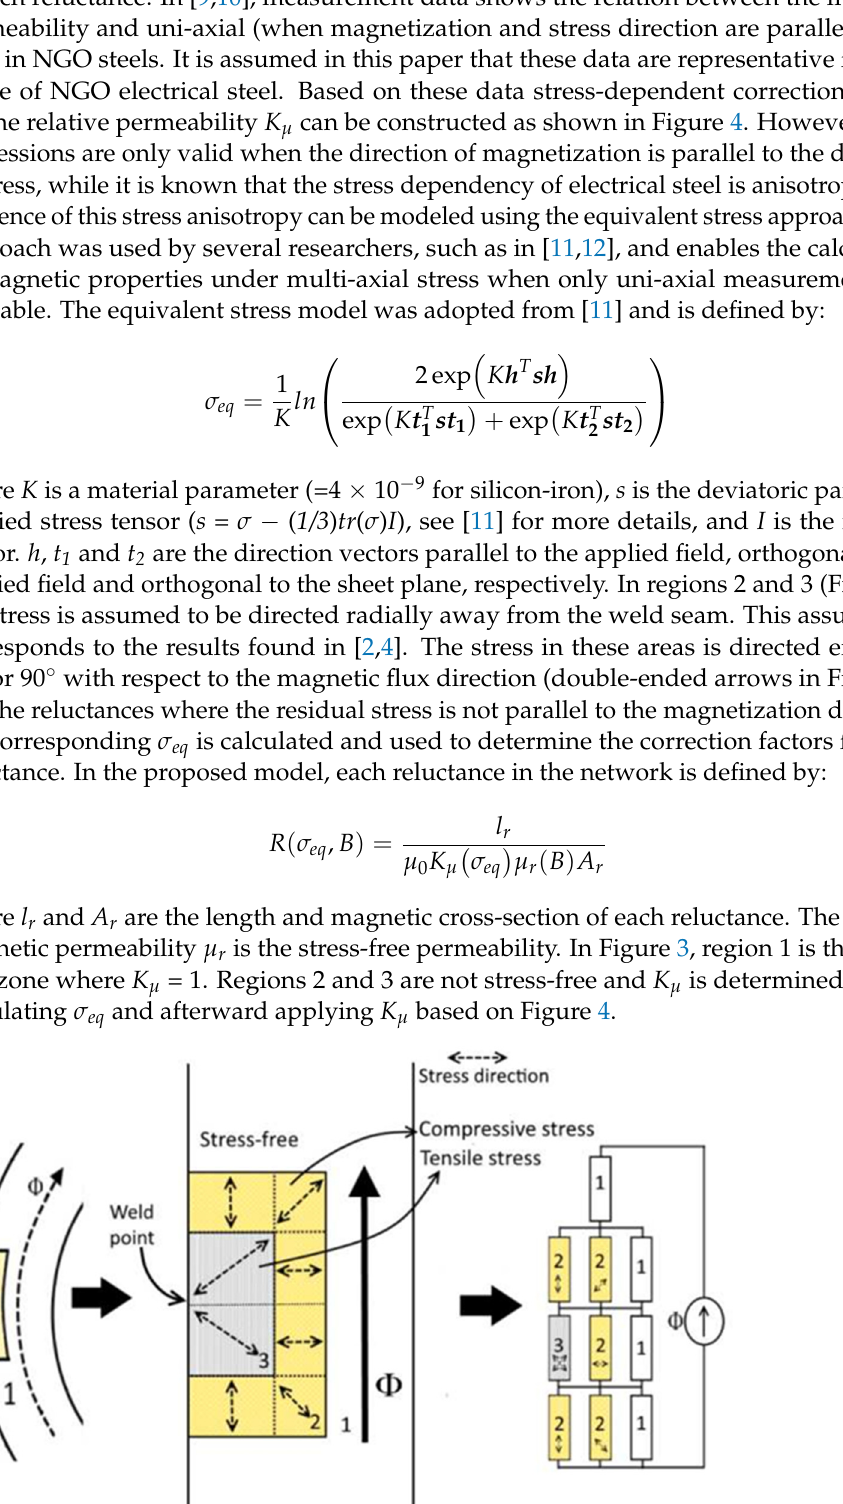
Figure 4. Approximated uni-axial relation between the stress correction factor of relative permea- bility K µ and the present stress state according to [9,10]. A factor higher than 1 means increased permeability due to stress. The relative permeability peaks at 140% of the stress-free permeability at a stress state of 10% of the material elastic limit, denoted by e/10 in this figure. This figure is valid for a material with elastic limit e = 350 MPa. For materials with a different elastic limit, the graph should be scaled accordingly. 2.2. Coarse-Scale Stress Dependent Loss Coefficients In the previous subsections, it is described how the MEC accounts for the residual stresses in and near the welding seam by assigning a stress-dependent magnetic permea- bility to each reluctance. Now, the MEC model can be solved for the flux density in each reluctance. However, the iron losses occurring in electrical steels also depend on stress [13]. In developing a stress-dependent iron loss model, a frequently used approach is to separate the core losses into hysteresis losses P hyst , classical (eddy current) losses P cl and excess losses P exc and to investigate the relation to stress for each component: